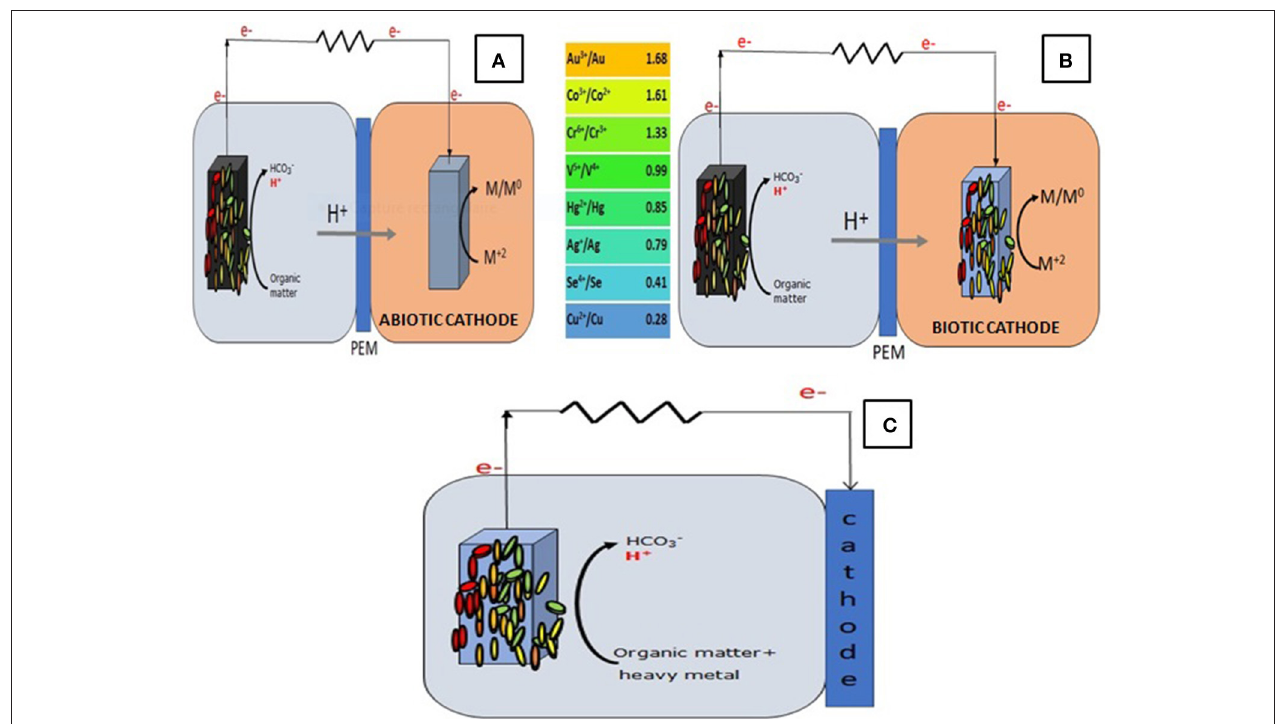
FIGURE 1 | The principle of heavy metal removal in (A) a DCMFC with an abiotic cathode; (B) a DCMFC with a biocathode; (C) an air-cathode